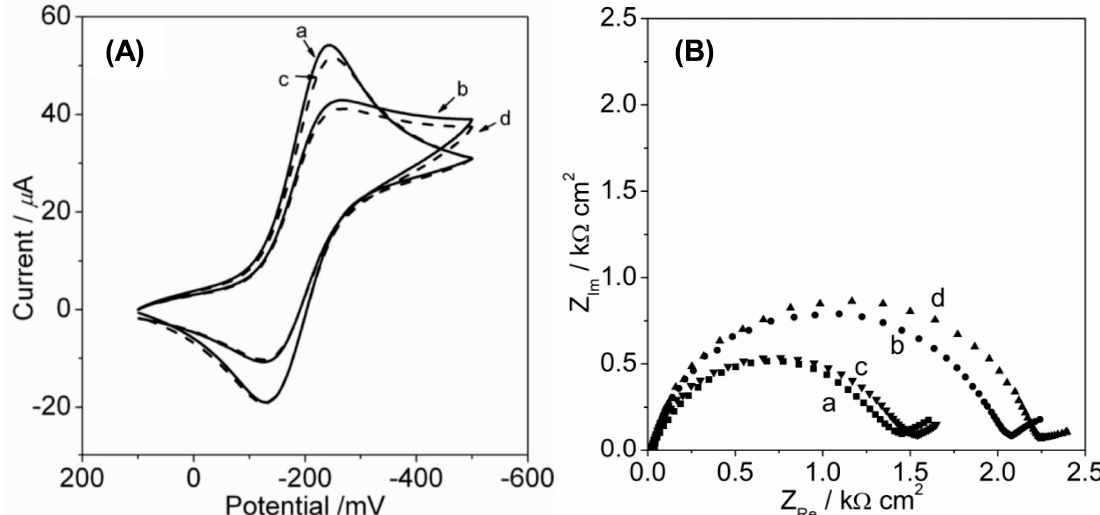
Figure 5. CV ( A ) and EIS ( B ) of 10 mM Ru(NH 3 ) 63+ in different electrolyte solutions on the binary OEG-SAM and the FS-SAM-modified gold electrodes: the binary OEG-SAM-modified gold electrodes in 0.1 M KCl (curve a ) and 0.1 M KPF 6 (curve b ), and the FS-SAM-modified gold electrodes in 0.1 M KCl (curve c ) and 0.1 M KPF 6 (curve d ). CV scan rate, 100 mV/s. pH: 7.0. Table 3. CV and EIS results for 10 mM Ru(NH 3 ) 63+ on different electrodes. Probe